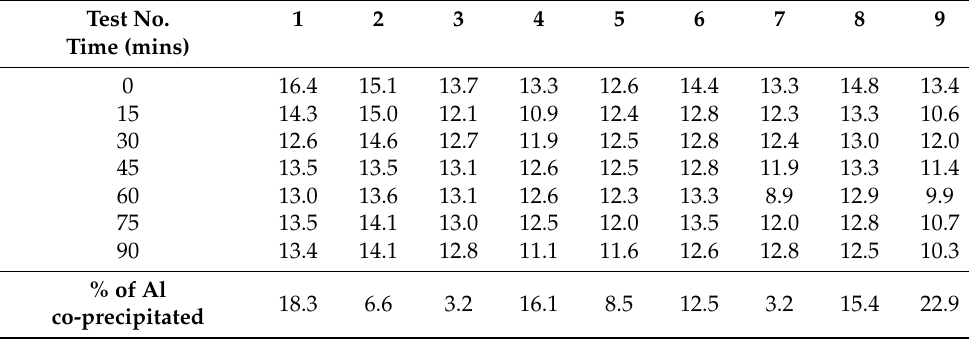
Table 3. Reduction in Al concentration (g/L) with